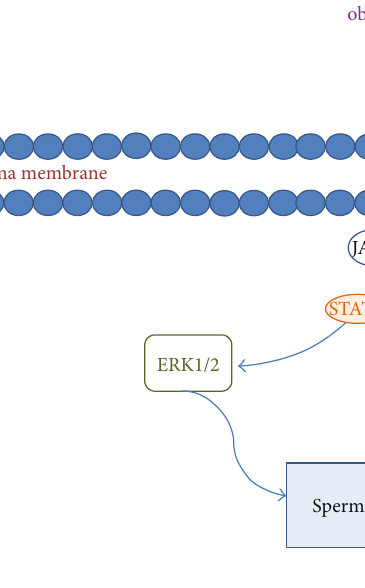
Figure 1: Leptin receptor and its interactions with JAK2 and STAT3 system to sperm capacitation